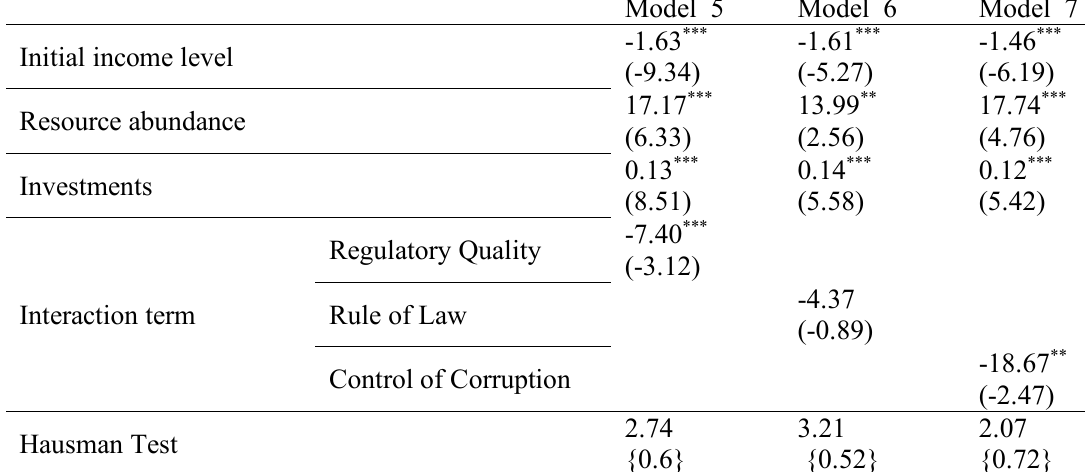
Table 3. Estimated results for the models 5 to